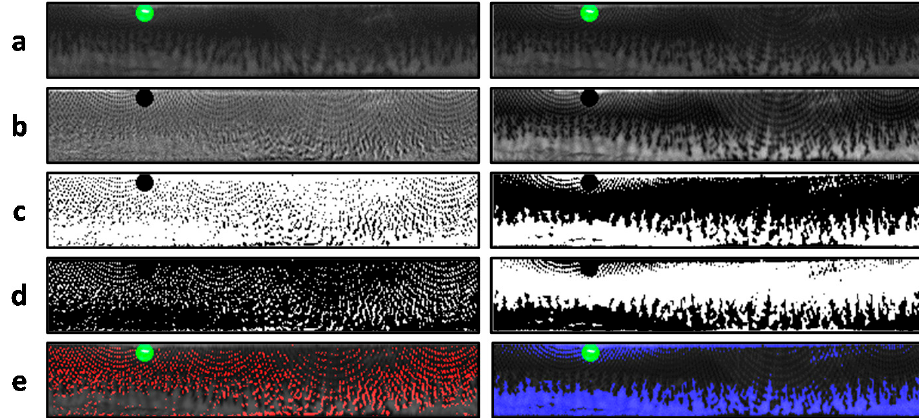
Figure 6. ( a ) The normalized images with specular points being removed; ( b ) Two estimated ICs through the ICA; ( c ) the binary masking of the ICs; ( d ) the complementary masks from the ICs; and ( e ) the inference two masks on the mixed image. The red and blue marks denote the inference of CCL pattern and iris texture, respectively. The green mark denotes the specular mask. It is noted that red mask had higher negentropy (as the Non-Gaussianity measure) in histogram analysis, thus esteemed as the CCL pattern. Figure 7a colored two masks in Cartesian coordinate for feature visualization. The mask in red displayed an annular dot pattern at the outer boundary around the iridal region. The texture of this estimated component (esteemed CCL) were in close agreement with the ground truth CCL picture in Figure 7b. The mask in blue displayed a sunflower shape, which was the remaining part of the iris texture.